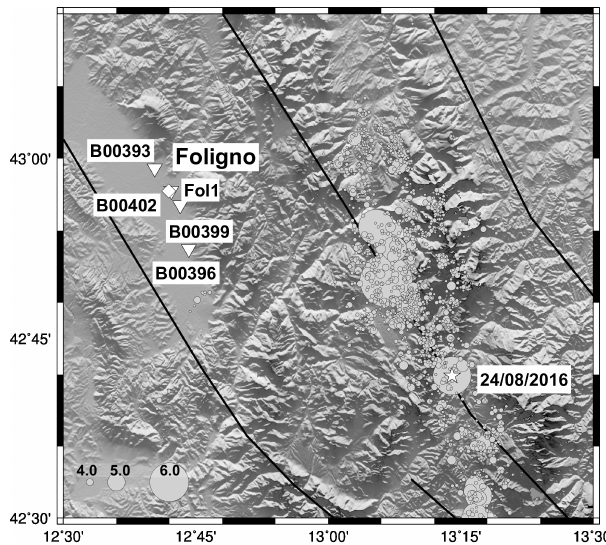
Figure 5. Location of the Foligno CGPS site (FOL1, diamond) equipped with a sampling rate of 1Hz and the closest (distance <10km) MEMS sensors in the area (inverted triangle). The thick back lines show the principal tectonic lineaments from the DISS database of Individual Seismogenic Sources (DISS, Basili et al., 2008). The epicenters of the events occurring during the period 1 June 2016–26 December 2017 are indicated with gray circles, the size of the symbols are proportionally to the moment magni- tude ( M w ) following the scale on the figure. The star indicates the location of the 24 August 2016 main shock. (Built with the Generic Mapping Tool software GMT – Creative Commons Attribution 4.0